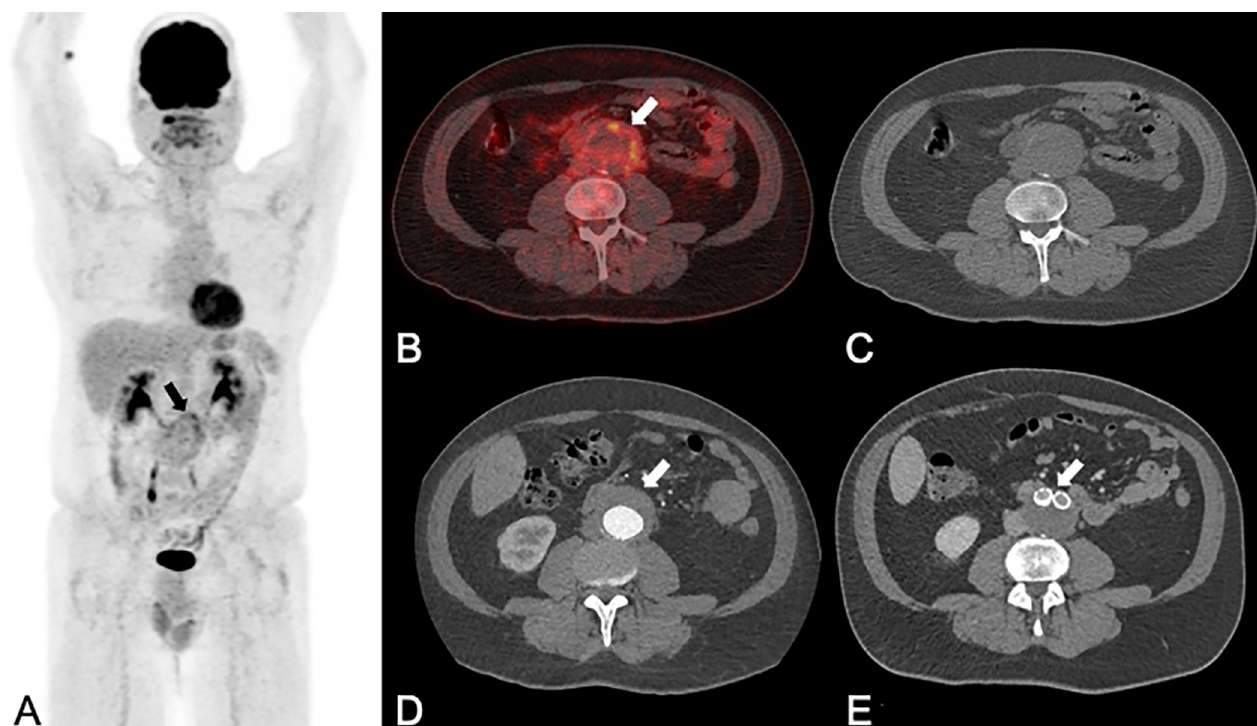
Fig 4. A 48-year-old man with a non-infected, non-inflammatory abdominal aortic aneurysm, initially diagnosed as an incidental finding on abdominal ultrasound. PET/CT (A: maximum intensity projection of PET; B: fused PET/CT images (B); C native CT images) and contrast-enhanced CT (CE-CT: D) showed a 55 mm large abdominal aortic aneurysm (white arrows in B and D) with increased FDG uptake (SUVmax 5.2, black arrow in A, white arrow in B) in the thickened (20 mm) aortic wall (white arrow in D). Both readers rated all imaging data set falsely: using PET/CT images and CE-CT images alone, one reader diagnosed a mycotic/infectious aneurysm while the other one diagnosed an inflammatory aneurysm; both readers suspected an inflammatory aneurysm on combined imaging. The patient was subsequently treated with percutaneous endovascular abdominal aortic aneurysm repair and neither antibiotic nor steroid therapy. The latest follow-up imaging four years after the initial diagnosis, showed no residual wall thickening abdominal aorta (E) and the patient had no abdominal symptoms.